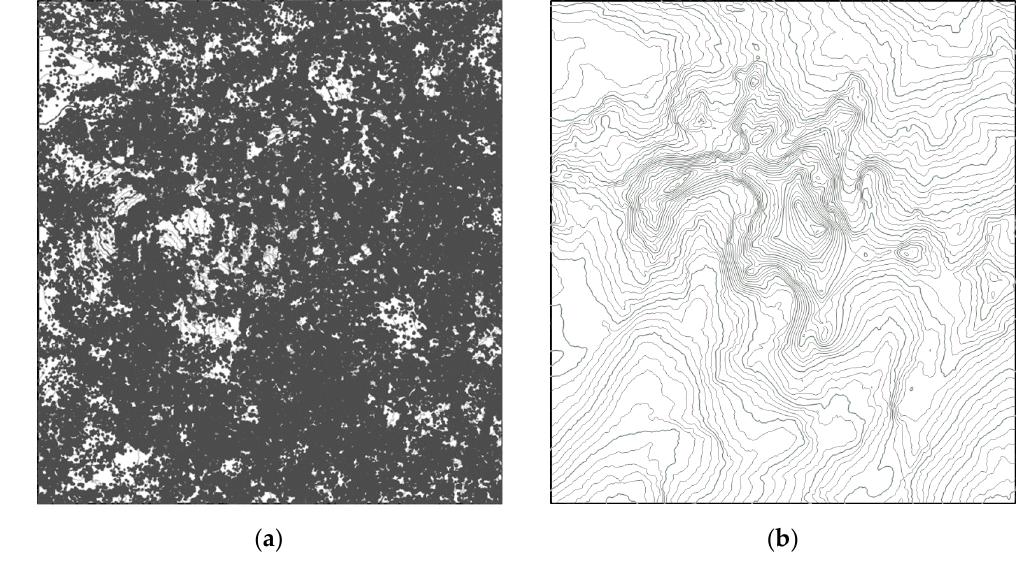
Figure 3. Contour lines (20 m) derived from PLE with different algorithms: ( a ) SGM (semi-global matching), and ( b ) ETM (extended terrain matching), which better resolves the features of the mountain summit. The minimum (maximum) elevations using SGM and ETM algorithm are 3168 m (7457 m) and 4204 m (5156 m), respectively. The altitude reference for the highest peak (Batian) is 5199 m.